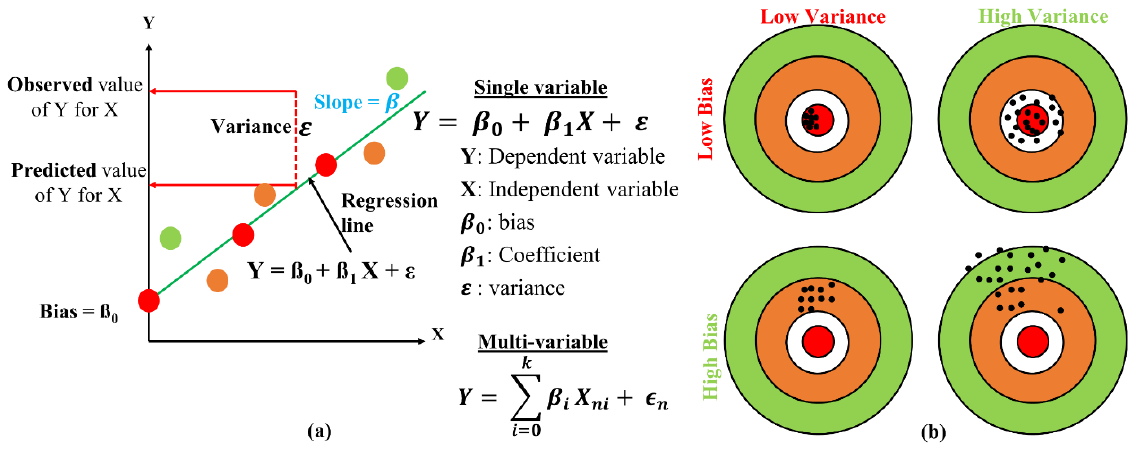
Figure 2. ( a ) Mathematical modeling of linear regression; ( b ) bias and variance.